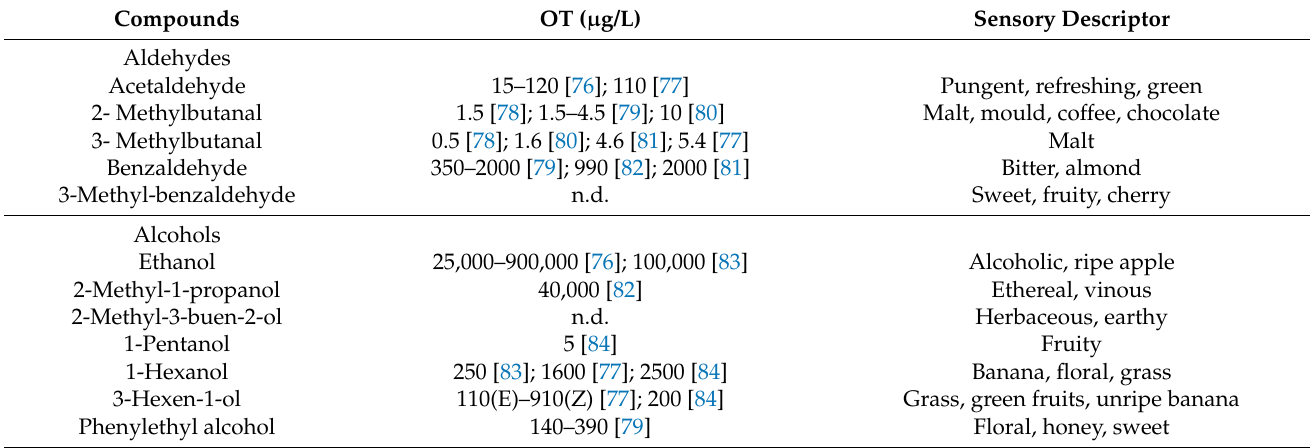
Table 7. Odour thresholds (OT) of volatile compounds found in PJs